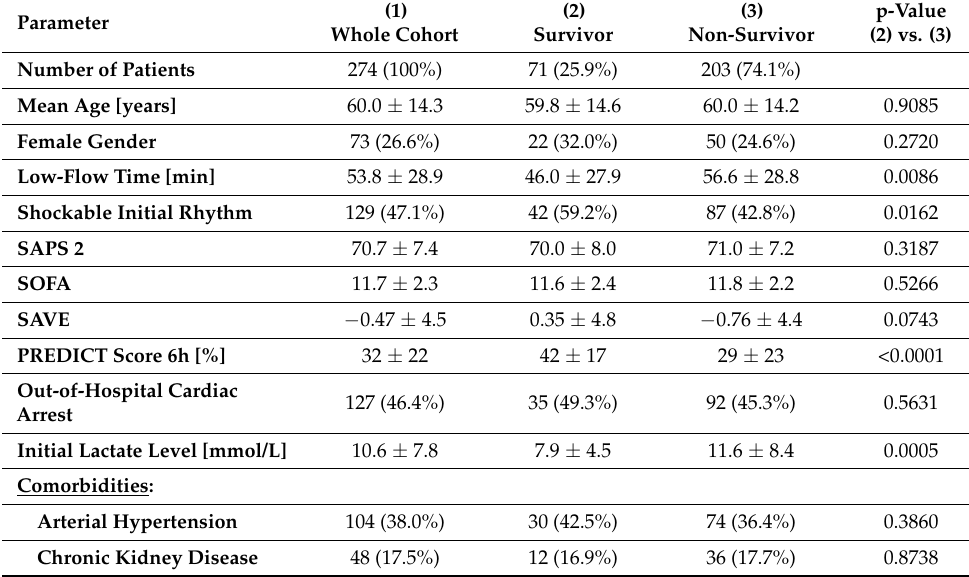
Table 2. Patients’ characteristics at time of